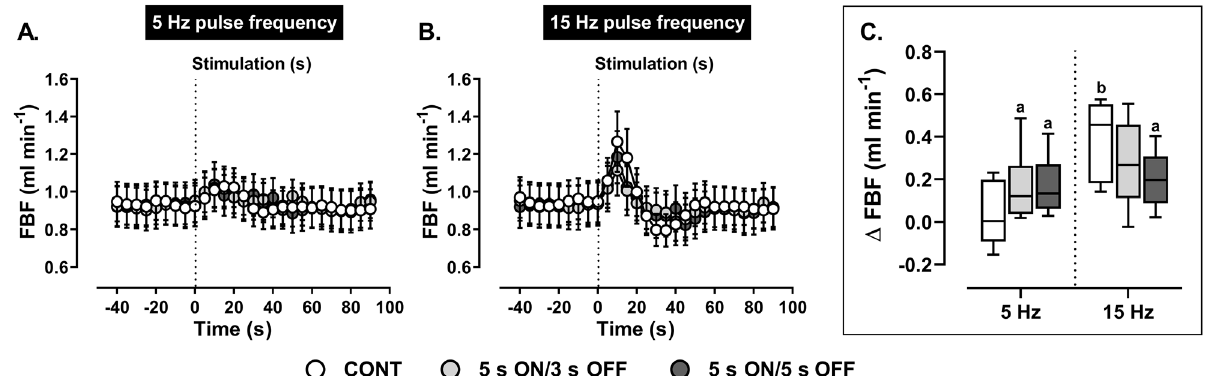
Figure 7. Effect of ( A ) low (5 Hz) and ( B ) high (15 Hz) frequency continuous (CONT) versus intermittent (5 s ON/3 s OFF and 5 s ON/5 s OFF) aortic depressor nerve (ADN) stimulation (0.4 mA, 0.2 ms for 20 s) on reflex increases in femoral blood flow (FBF) in pentobarbital-anesthetized spontaneously hypertensive rats. ( A,B ) The time trend for the reflex FBF response to ADN stimulation, while ( C ) shows absolute changes (ml min −1 ) in FBF in response to ADN stimulation. Results are expressed as mean ± SEM ( n = 8), analyzed by a two-way ANOVA followed by followed by Bonferroni’s post hoc test a: P < 0.05 versus continuous stimulation for each frequency and b: P < 0.05 versus respective stimulation across frequencies.